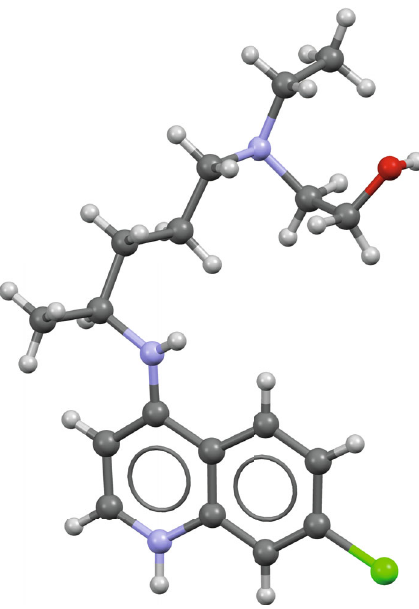
Figure 6: Molecular structure of